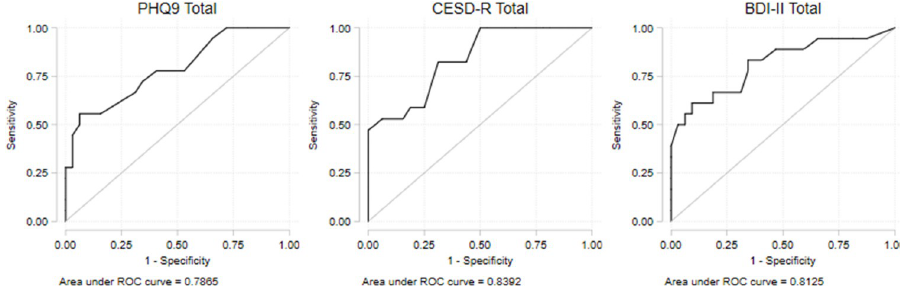
Fig 1. Receiver Operating Characteristic (ROC) curves depicting the accuracy of the PHQ-9, CESD-R and BDI-II across the full range of each tool with respect to CIS-R diagnostic grouping, in 50 South Asian HD patients.